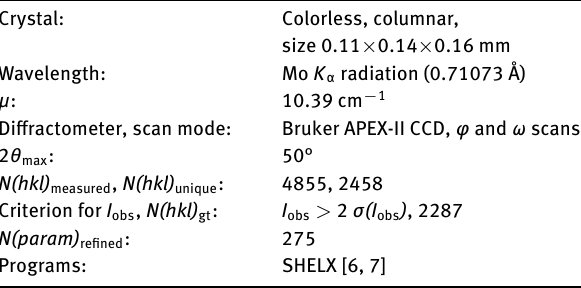
Table 1: Data collection and handling.